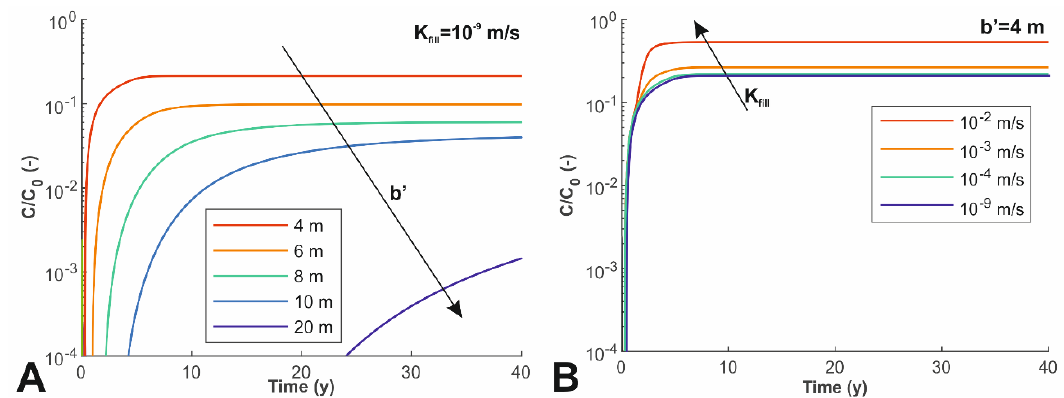
Figure 5. Time trends of contaminant concentration at the top of the deep aquifer: ( A ) in the reference cases with 𝐾 𝑓𝑖𝑙𝑙 = 𝐾 𝑎𝑡 = 10 −9 m/s and ( B ) for different values of 𝐾 𝑓𝑖𝑙𝑙 , 200 m downstream the borehole outlet and aligned with it along the groundwater flow direction.